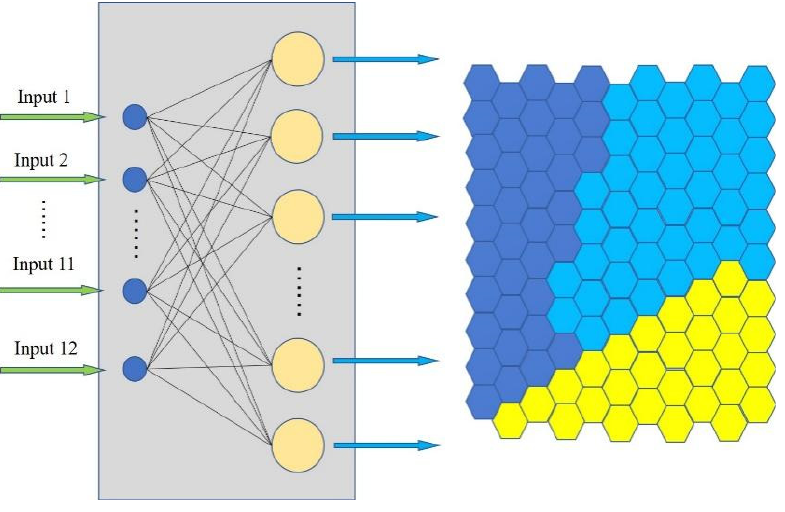
Figure 6. The architecture of the SOM.